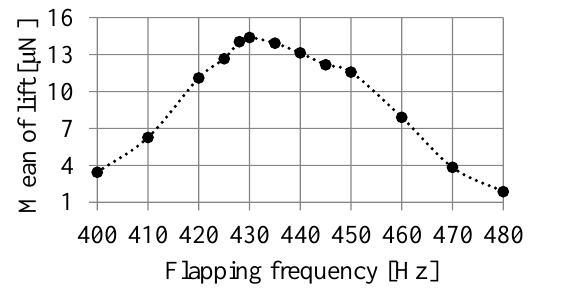
Figure 16. Wing’s flapping motion and the surrounding flow during the upstroke, where the wing flaps from right to left in the left column, and the wing flaps from left to right in the right column: ( a ) The time instant of 8.48 cycle; ( b ) The time instant of 8.60 cycle; ( c ) The time instant of 8.72 cycle; ( d ) The time instant of 8.84 cycle; ( e ) The time instant of 8.96 cycle; ( f ) The time instant of 9.08 cycle; ( g ) The time instant of 9.20 cycle; ( h ) The time instant of 9.32 cycle. Finally, the DW search was done based on the frequency response functions (FRFs).